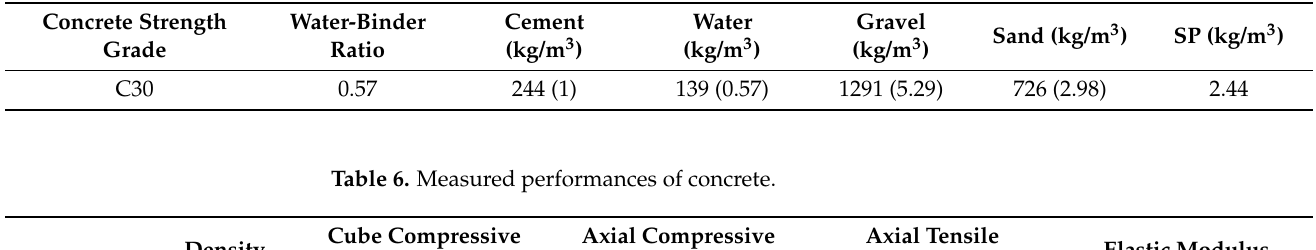
Table 5. Mix Proportions.